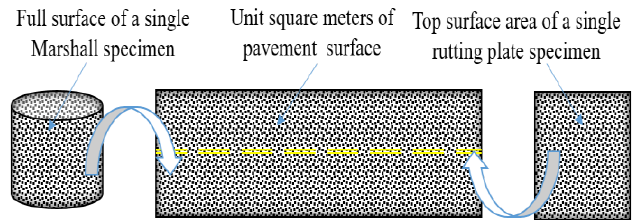
Figure 9. Area conversion schematic diagram.